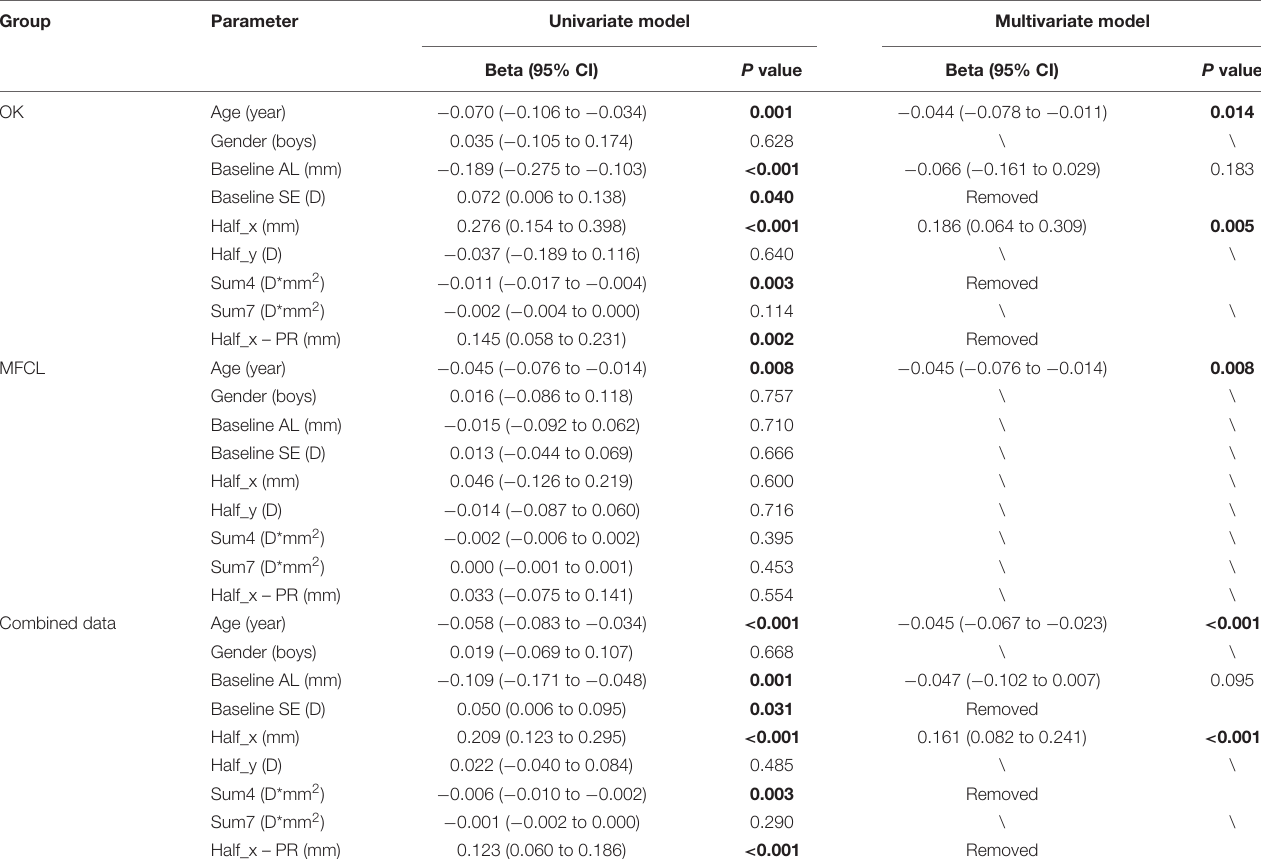
TABLE 3 | Linear regression analysis of AL elongation association with baseline data and RCRPS parameters. Group